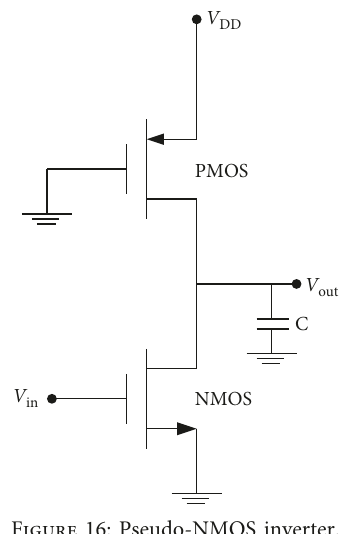
Figure 16: Pseudo-NMOS